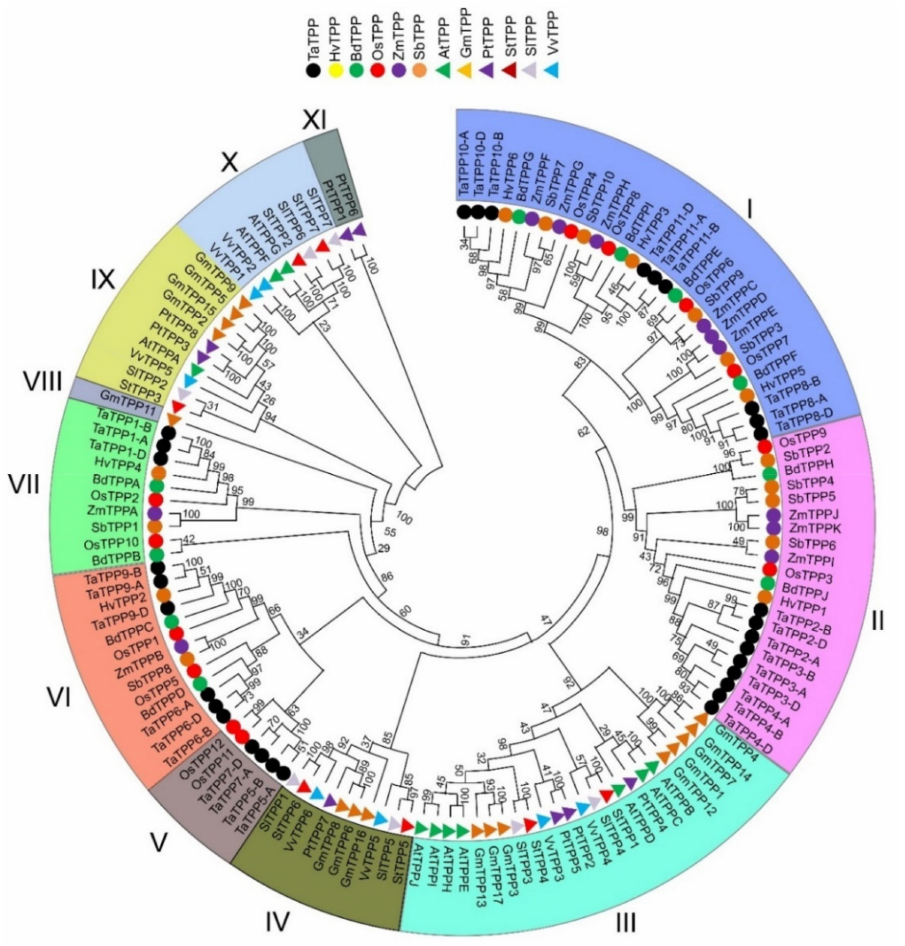
Figure 3. Phylogenetic analysis of TaTPP proteins. The tree was generated using MEGA X by the maximum likelihood method with 1000 bootstrap values. All the species and protein ID used for constructing tree were presented in Table